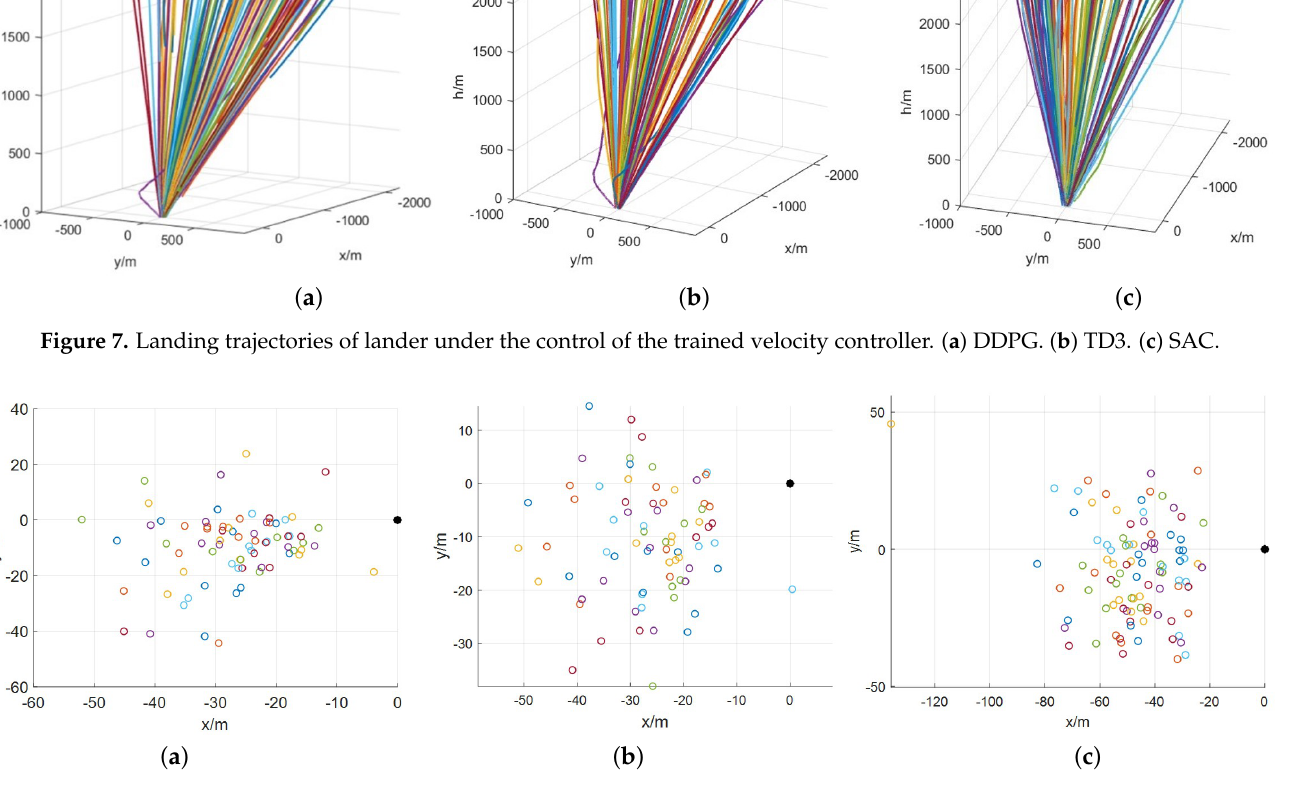
Figure 8. 2D distribution of landing points. ( a ) DDPG. ( b ) TD3. ( c )